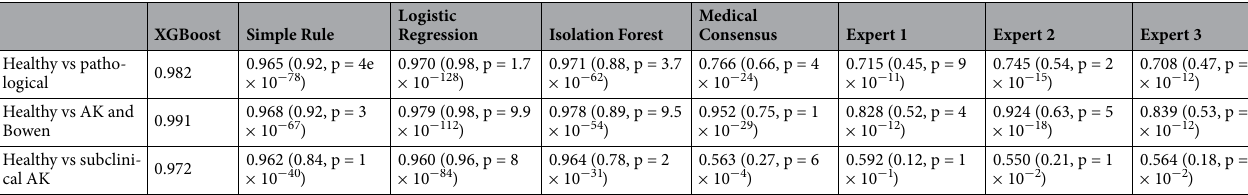
− 7 (Fig. 2b: t-value = 5.09, p-value = 8.65 × 10 ). Distances between nuclei from border to border (Fig. 2e: t-value − 30 = 13.9, p-value = 2.06 × 10 ) and from center to center (Fig. 2f: t-value = 15.5, p-value = 4.79 × 10 greater for pathological skins.